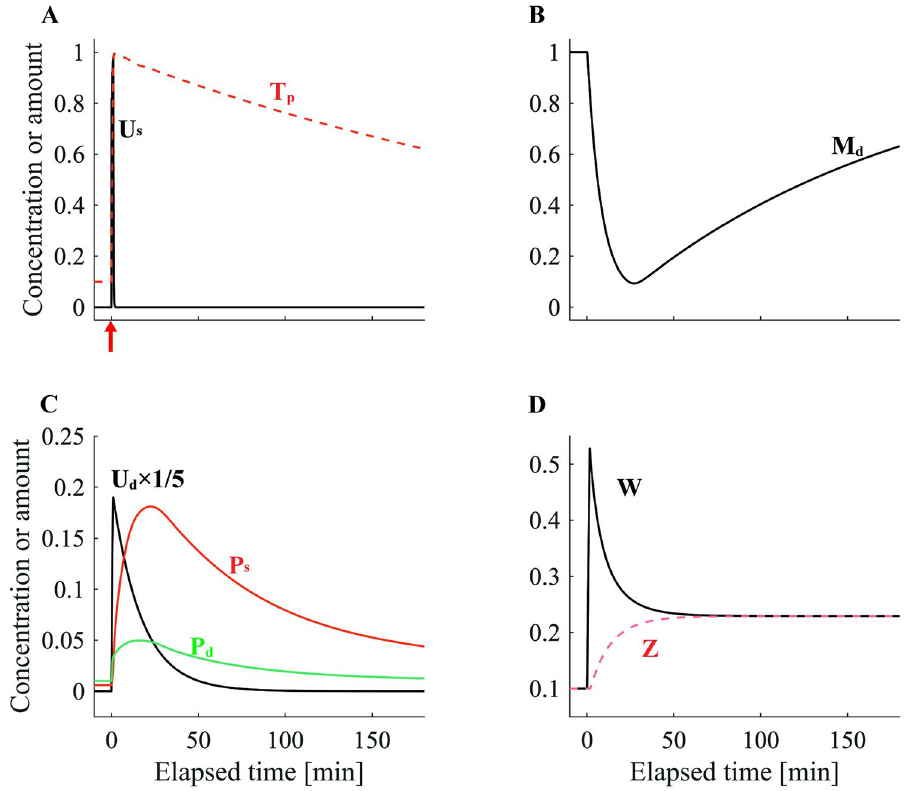
Fig 3. The dynamics of each variable in l-LTP. The variables illustrated in (A)–(D) are the same as those described in the caption of Fig 2. For (A), the red arrow indicates the timing of the l-LTP–inducing stimulation protocol.